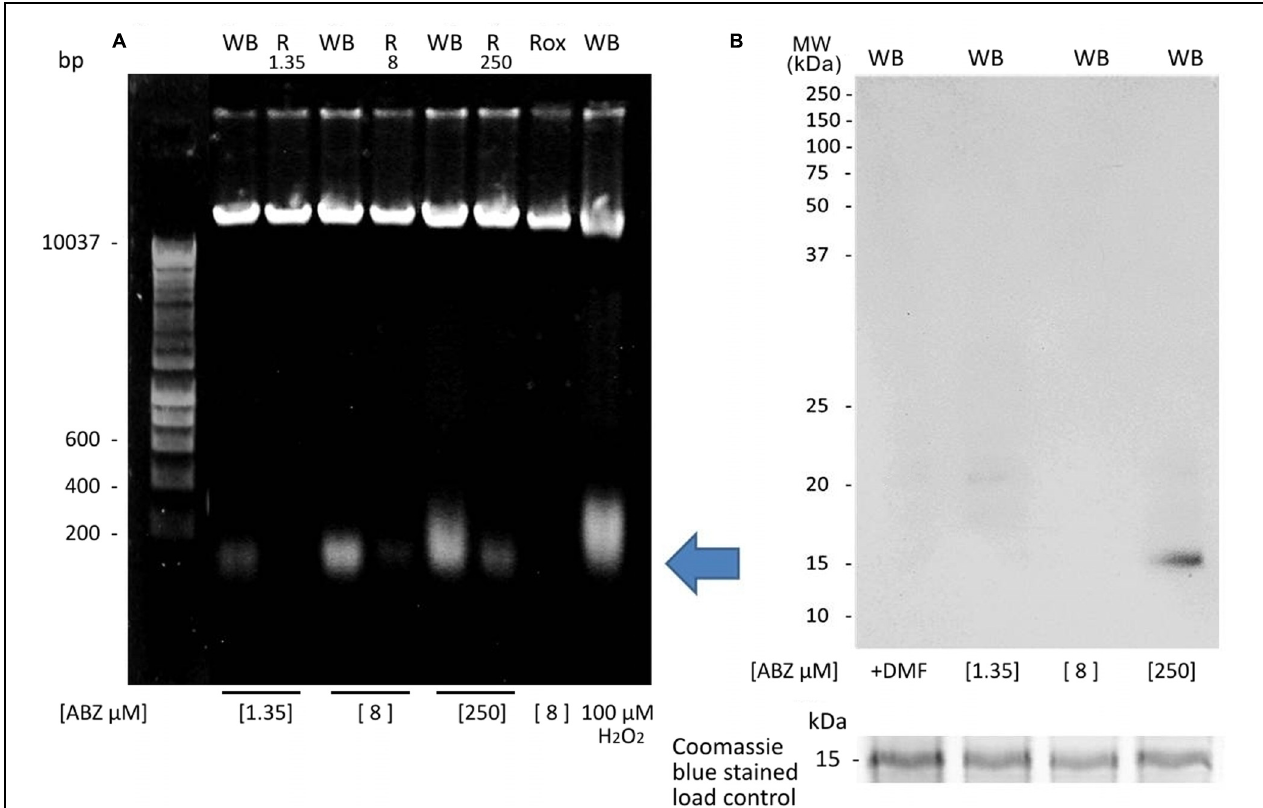
FIGURE 6 | DNA fragmentation and histone H2AX phosphorylation in G. duodenalis trophozoites exposed to ABZ. (A) WB strain trophozoites (WB) were exposed to 1.35, 8, and 250 μ M of ABZ or to 100 μ M of H 2 O 2 in parallel with the resistance clones (R1.35, R.8, R.250) and the H 2 O 2 -resistant strain (ROX) which was exposed only to 8 μ M of ABZ. Then the cells were incubated for 16 h at 37 ◦ C. Total DNA was extracted, treated with RNAse and analyzed in agarose gels. DNA degradation zone is shown by an arrow. DNA degradation was mainly observed in the WB strain treated with the different